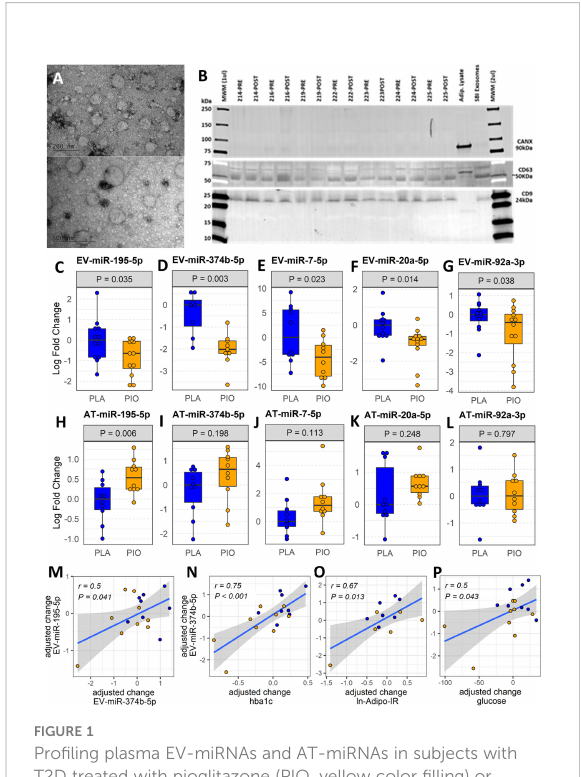
FIGURE 1 Pro fi ling plasma EV-miRNAs and AT-miRNAs in subjects with T2D treated with pioglitazone (PIO, yellow color fi lling) or placebo (PLA, blue color fi lling). (A) Transmission electron micrographs of representative EV preparation. (B) Western blot for exosomal (CD9, CD63) and non-exosomal (CANX) protein markers. Blots show samples from 7 out of the 12 patients from both groups, prior and after treatment (no signi fi cant differences found by densitometry quanti fi cation of protein band content). Adipocyte lysate and SBI Exosome lysate were used as controls. (C-G) Baseline-adjusted boxplots of fi ve signi fi cantly downregulated miRNAs in circulating EVs from T2D subjects treated with PIO, compared to PLA. (H-L) Baseline-adjusted boxplots of miRNA expression in adipose tissue (AT) from T2D subjects treated with PIO, compared to PLA group. (M-P) Signi fi cant partial correlations between EV-miRNAs and relevant clinical